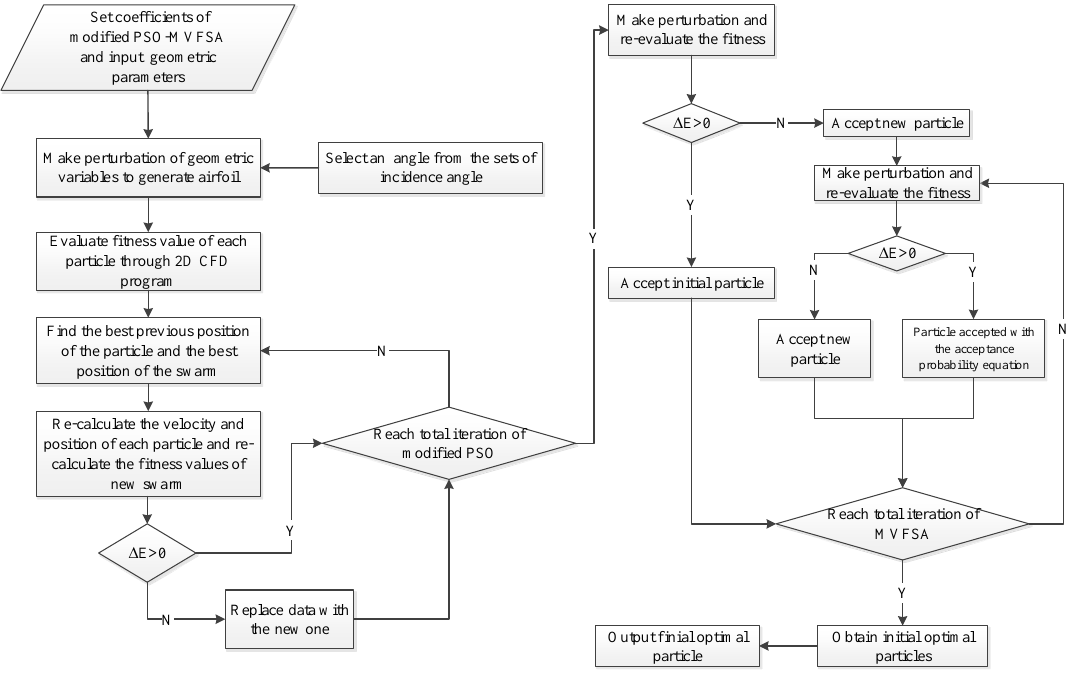
Figure 6. Flow chart of the whole aerodynamic optimization process.